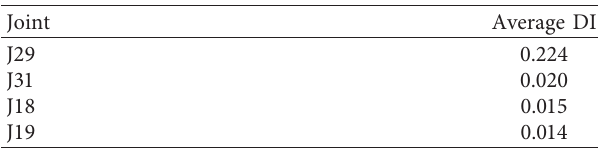
Figure 9: Normalized damage indicator matrix. Energy ( E ) is excluded from the feature vector. Table 3: Non-normalized mean DI